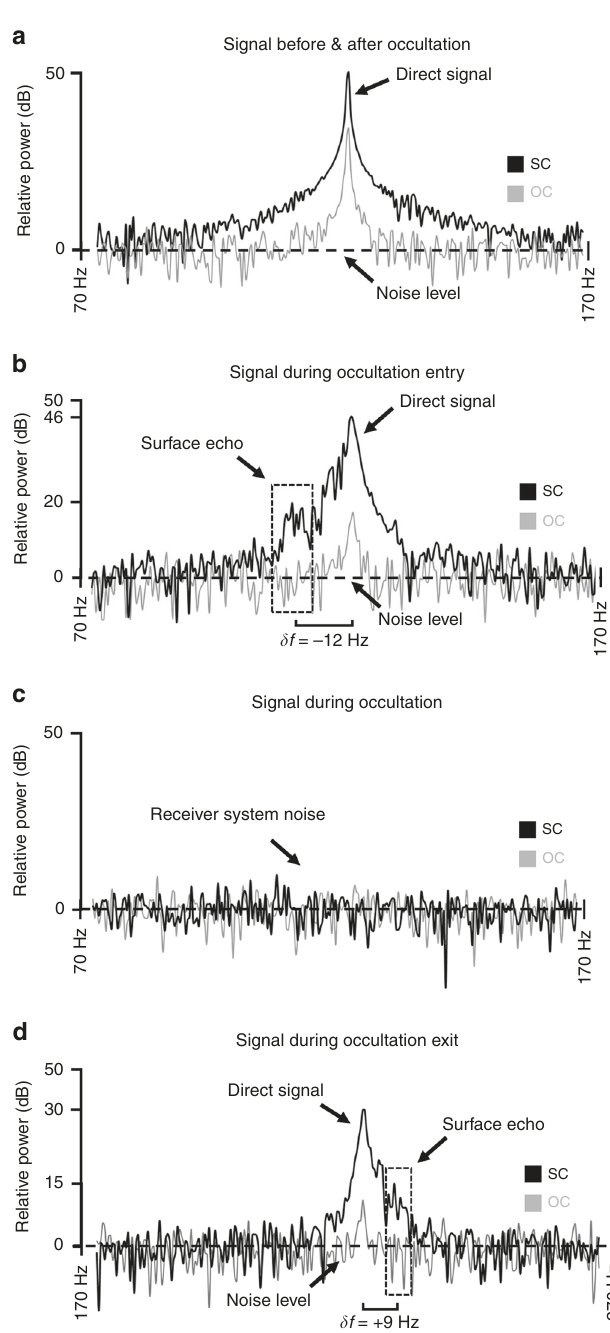
Fig. 1 Typical progression of received radar signal over the course of an occultation. The frequency spectra show power received in the same circular ( SC ) and opposite circular ( OC ) polarization a before/after occultation, b during entry into occultation, c during occultation, and d during exit from occultation of orbit 355. All surface echoes during occultation entry are Doppler-shifted to lower frequencies than the direct signal, while all surface echoes during occultation exit exhibit Doppler shifts to higher frequencies than the direct